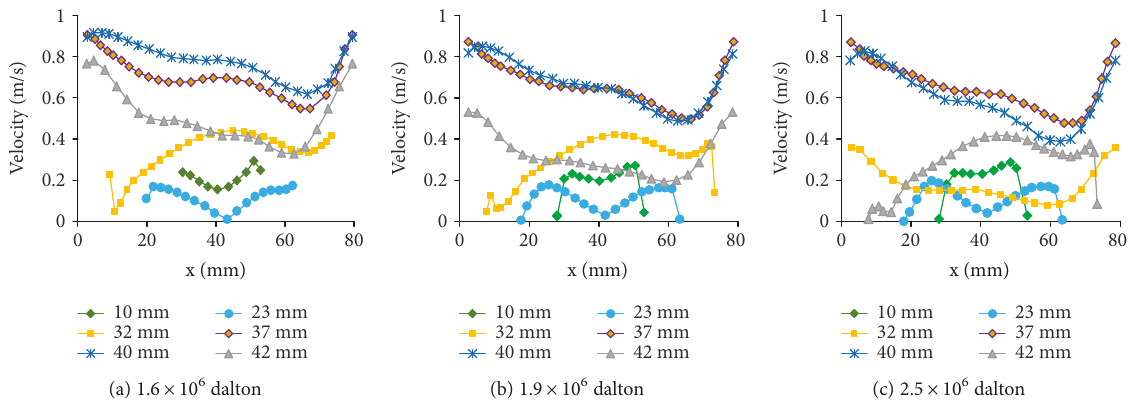
Figure 8: Velocity distribution of the polymer solution at 30 m 3 /d through the partially pressured injection tool with 18 slots.